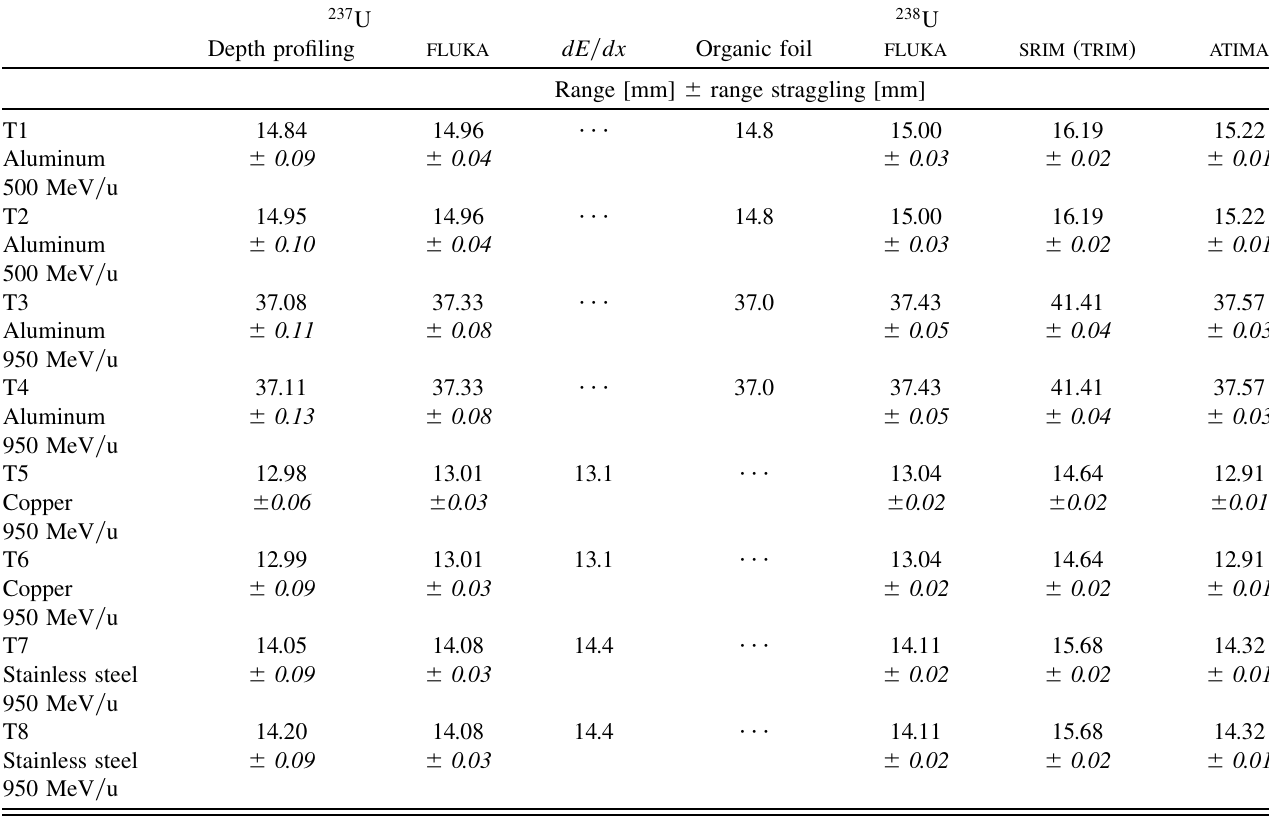
TABLE V. Range and range straggling of the 237 U fragments and the 238 U primary ions in aluminum, copper, and stainless-steel targets measured experimentally and calculated using computer codes. The energy of the primary beam presented in the table is the synchrotron nominal energy. Energy losses of the primary beam in vacuum window, air drift space, and SEETRAM are taken into account. In case of the FLUKA simulations and depth-profiling experiments, the range and the range straggling are calculated according to Eqs. (8) and (9), respectively. This range straggling does not take into account the uncertainties of the input quantities and must not be interpreted as the uncertainties of the presented data. The beam momentum spread in FLUKA simulations was 5 (cid:1) 10 (cid:2) 4 ( 1 (cid:3)